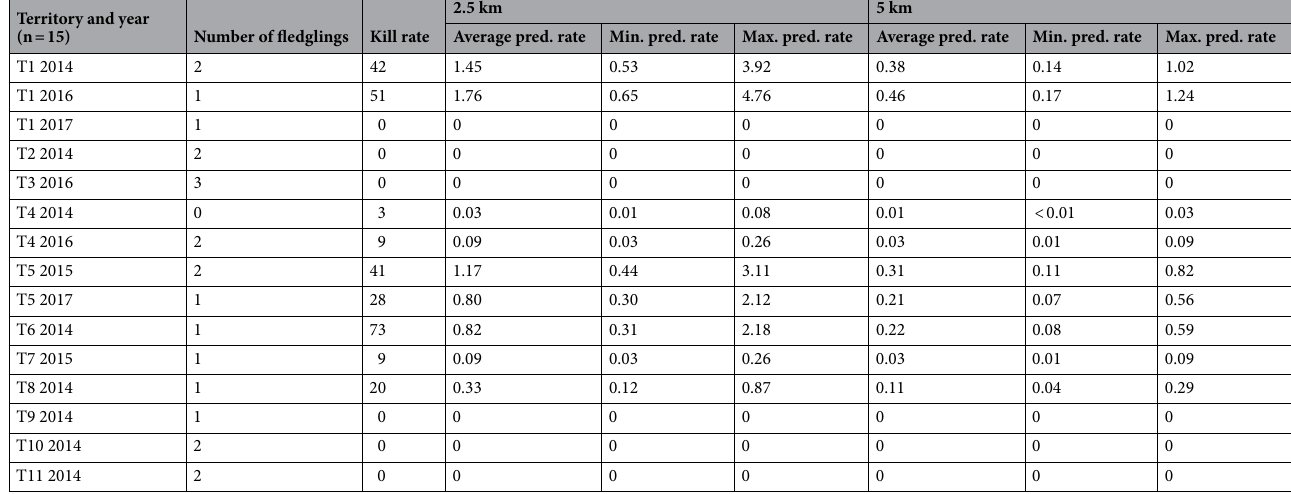
Table 2. Breeding success of golden eagles and kill rates and predation rates by golden eagles on spur-thighed tortoises in SE Spain according to eagle territories, years and territorial